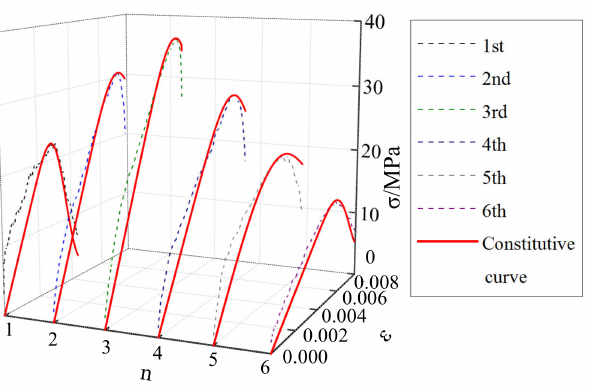
Figure 13. Comparison between the 0.15 MPa-pressure cyclic-impact test results and the theoretical results for mudstone.